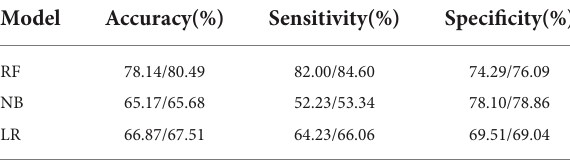
TABLE 4 Performance evaluation of the three classifiers on the testing set